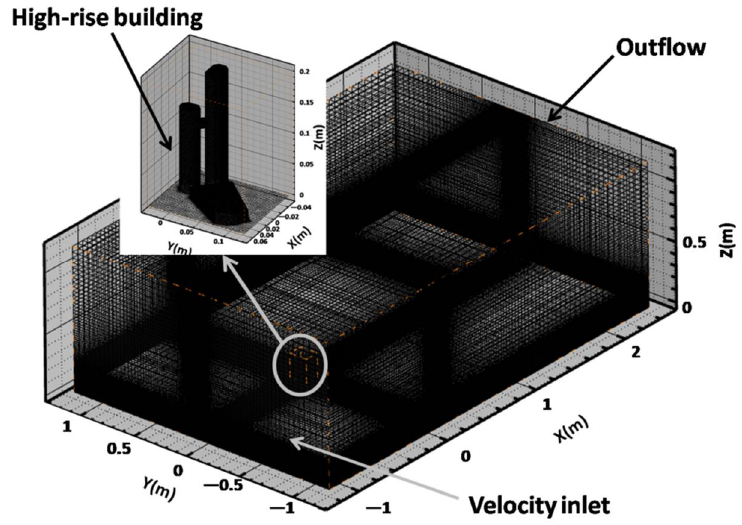
Figure 3. Computational domain